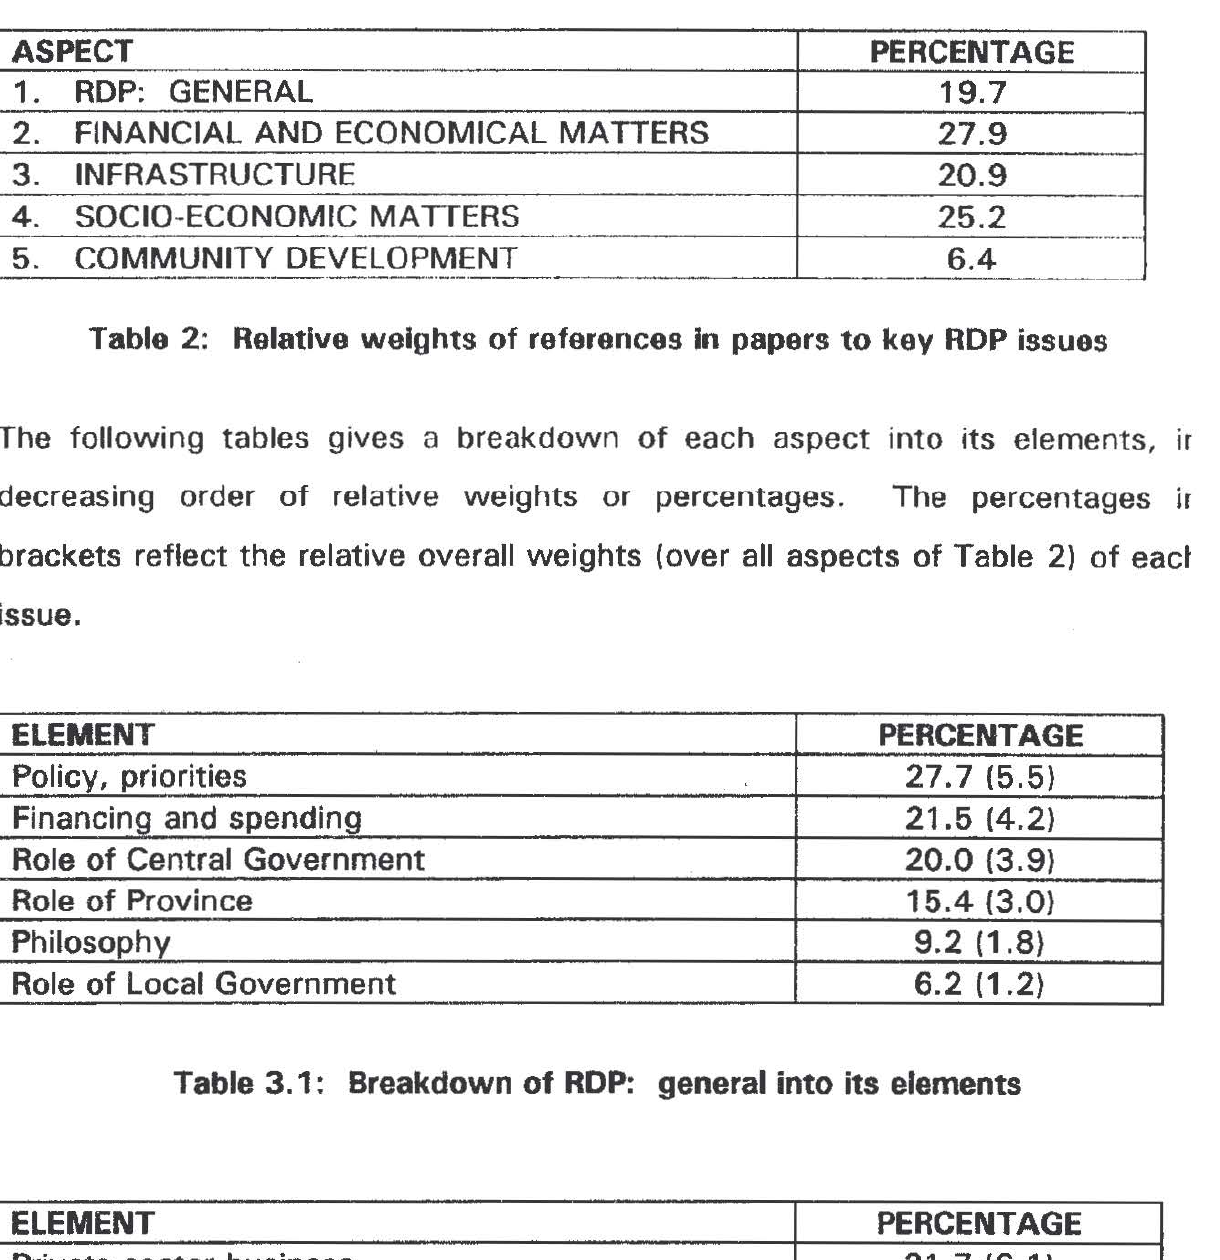
Table 3. 1: Breakdown of ADP: general into its elements